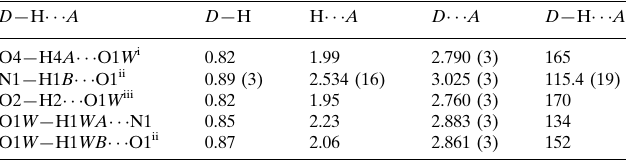
Hydrogen-bond geometry (A˚ , (cid:2)